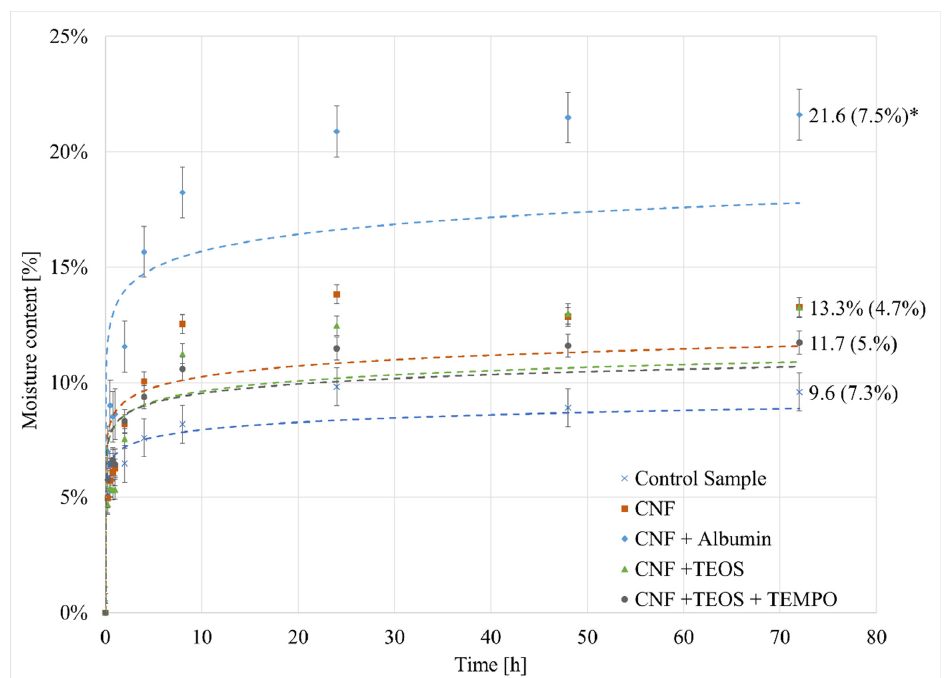
Figure 4. Moisture content (%) of tested CNF samples. * The relative standard deviation (RSD) (%) values are shown in parentheses.